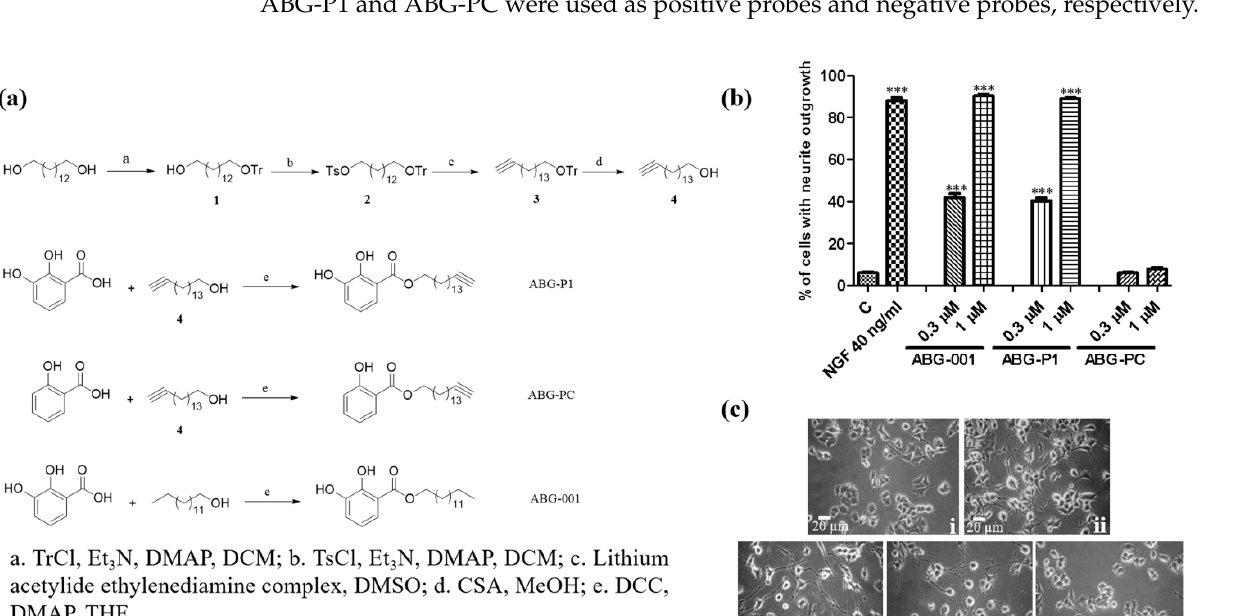
Figure 1. Microarray analytical results of ABG-001. ( a ) Profiles of differentially expressed mRNAs in the control group and ABG-001 treated groups. ( b ) Significant GO categories of the differentially expressed genes for the upregulated and downregulated genes. ( c ) Heatmap of differential expression genes compared with control group and ABG-001 groups. The red and green colors represent the upregulation and downregulation of genes expression, respectively.